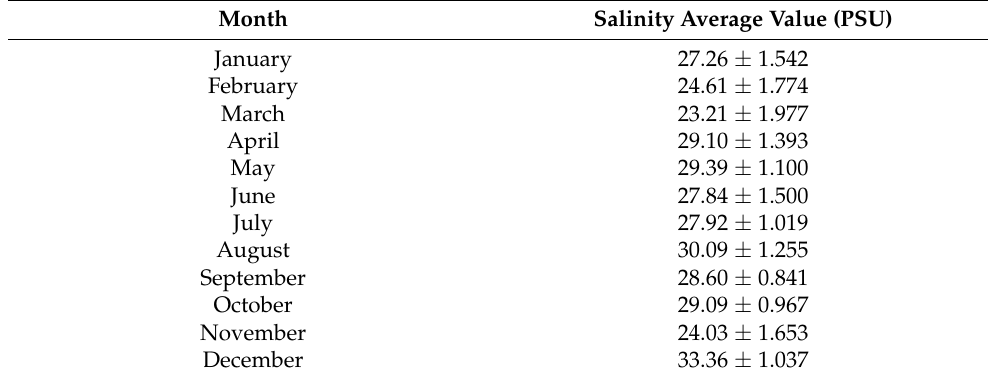
Table 1. Salinity average value (mean ± SE) from January to December 2019 in the Acquatina di Frigole lagoon. PSU: Practical Salinity